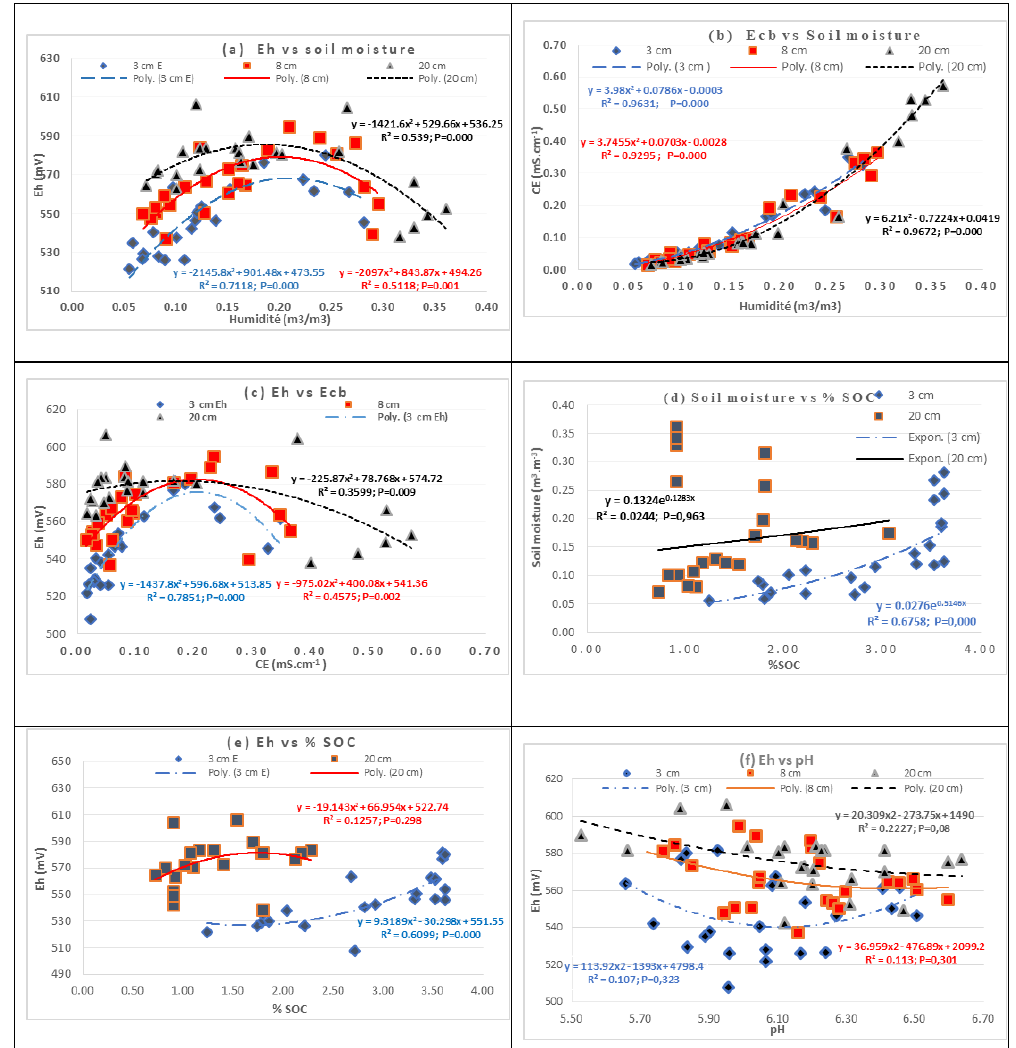
Figure 10. Relationship between soil moisture and Eh ( a ). Correlation of soil moisture and electrical conductivity and its consequence on Eh. ( b , c ) Effect of soil organic carbon (SOC) on soil moisture and its consequence on Eh ( d,e ). Relationship between pH and Eh ( f ). The regression equations and correlation coefficients (R 2 and p values) are determined for each depth.